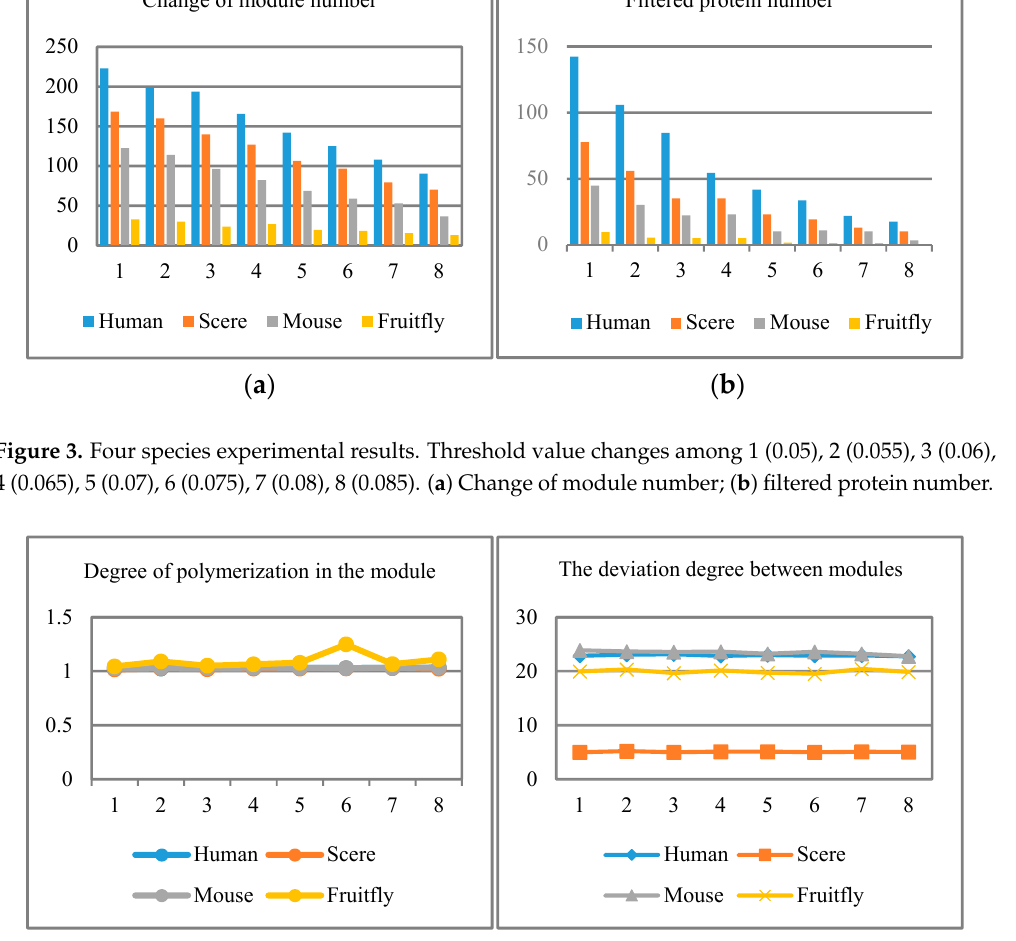
( a ) ( b ) Figure 6. ( a ) Degree of polymerization in the module; ( b ) degree of deviation between modules. Meanwhile, Table 5 indicates that the number of function module generated by SSO algorithm is a bit lower than PSO in fruitfly species. This may be because of the small number of protein nodes in fruitfly species. Table 6 shows the filtered protein number for PSO and SSO algorithms, which indicates that SSO is significantly better than those of PSO, especially when the number of protein increases. Table 7 shows the degree of polymerization in the module for both PSO and SSO algorithms. A higher value indicates higher similarity in the module. The result also reveals that the two algorithms are relatively close, however, the SSO algorithm has better stability. Table 5. Change of module number for PSO and SSO algorithms. Category